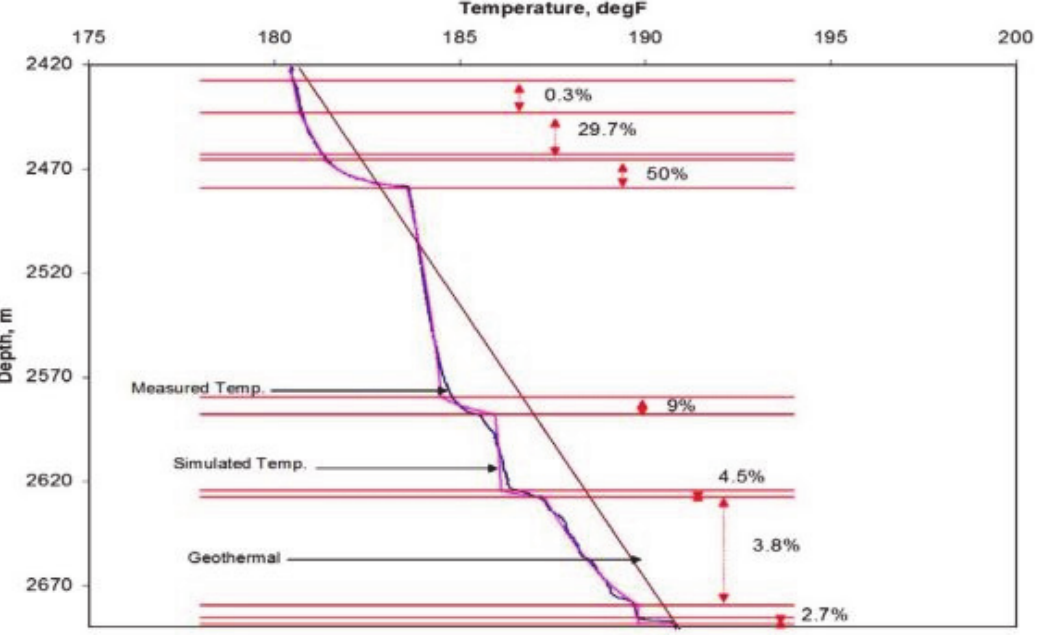
Figure 6. Gas production profiling using DTS data